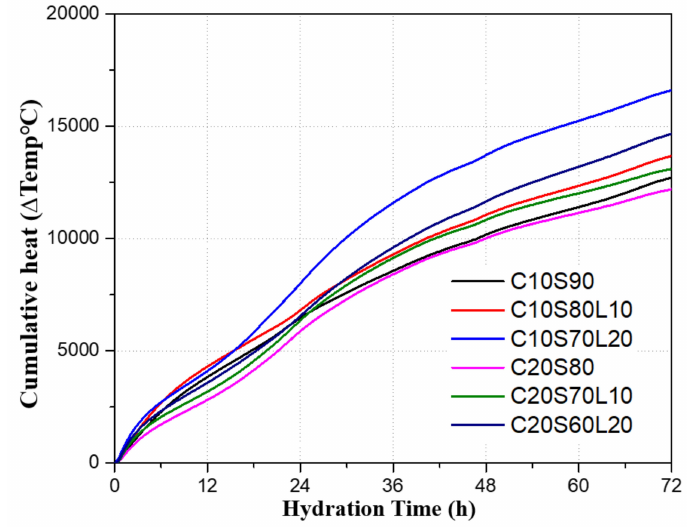
Figure 6. Cumulative heat release of AAS mixtures with di ff erent OPC and LBD